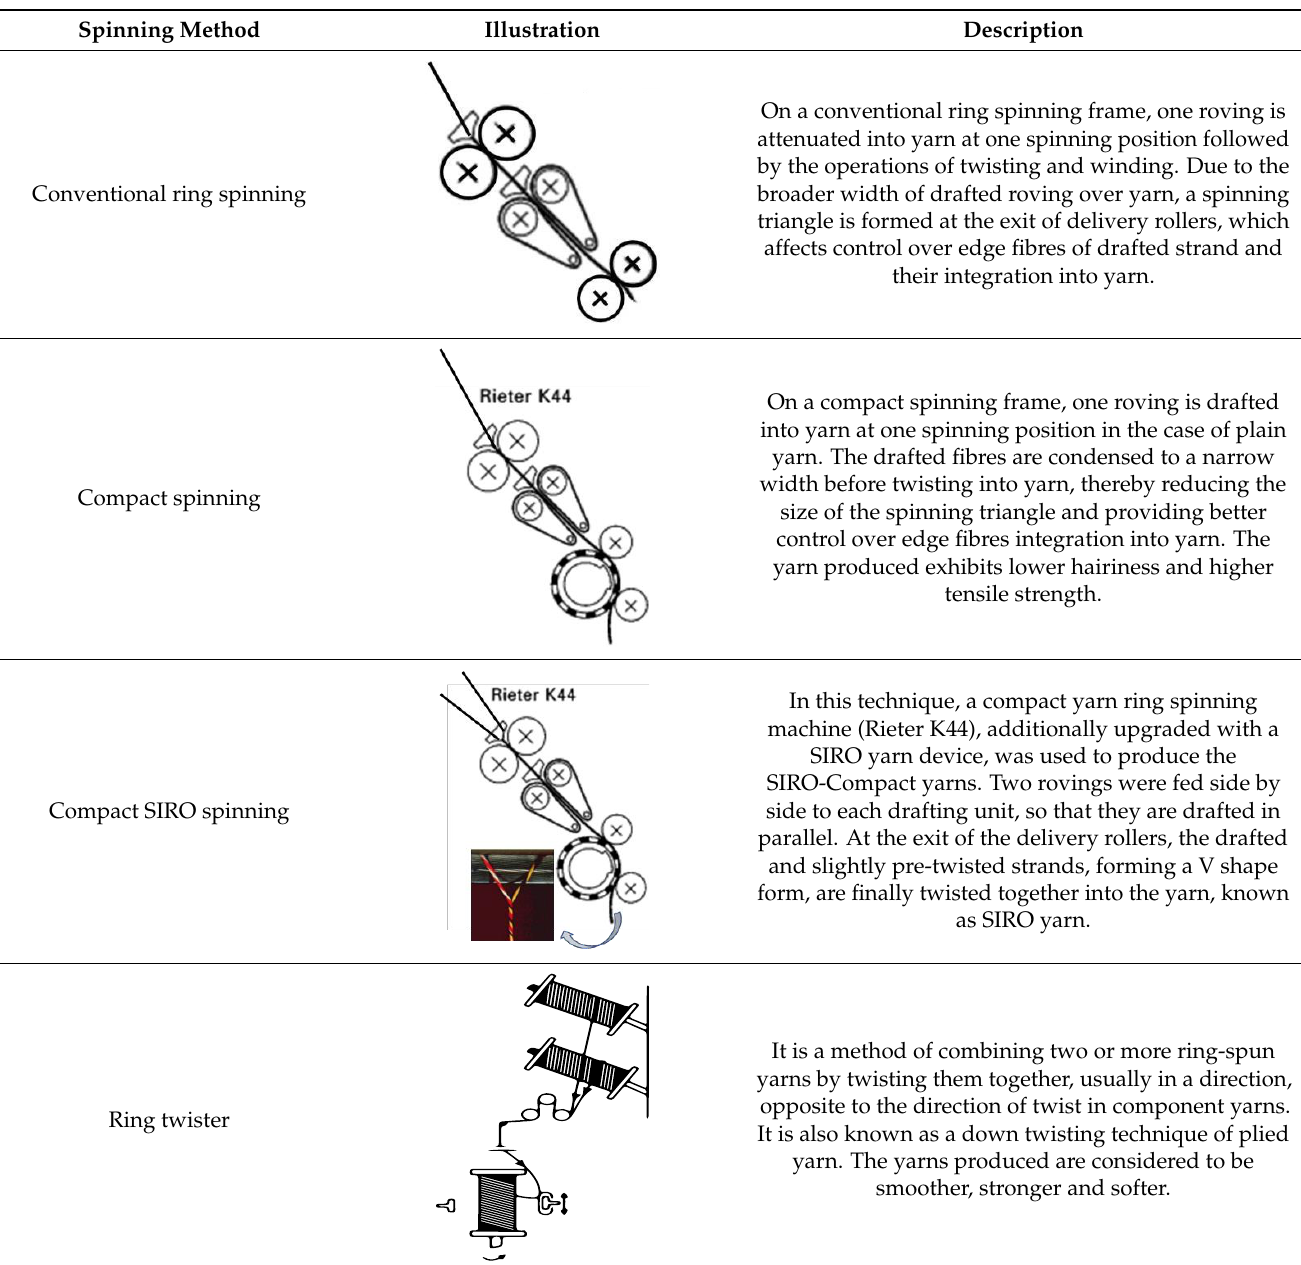
Table 2. Brief description of spinning techniques.